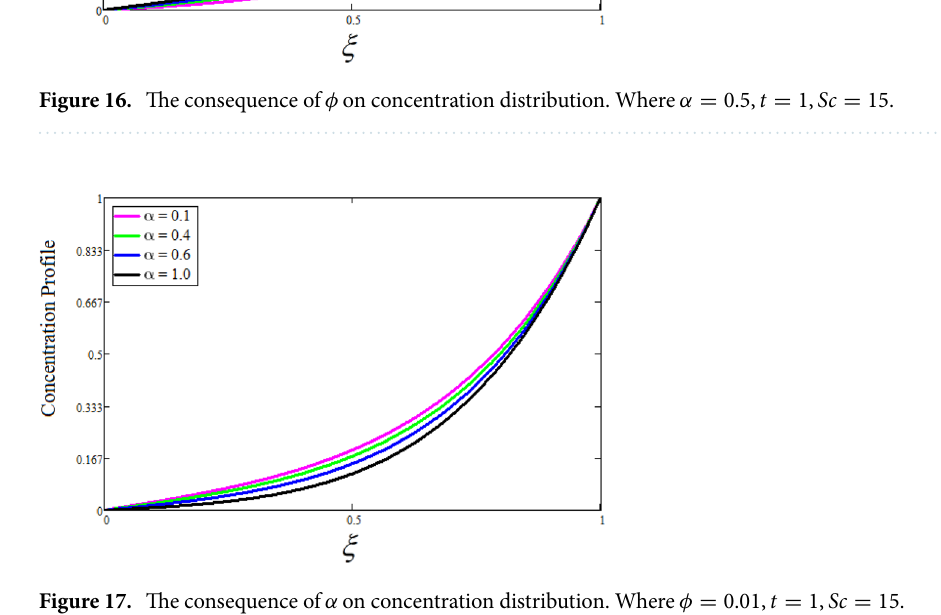
Figure 17. The consequence of α on concentration distribution. Where φ = 0.01, t = 1, Sc =